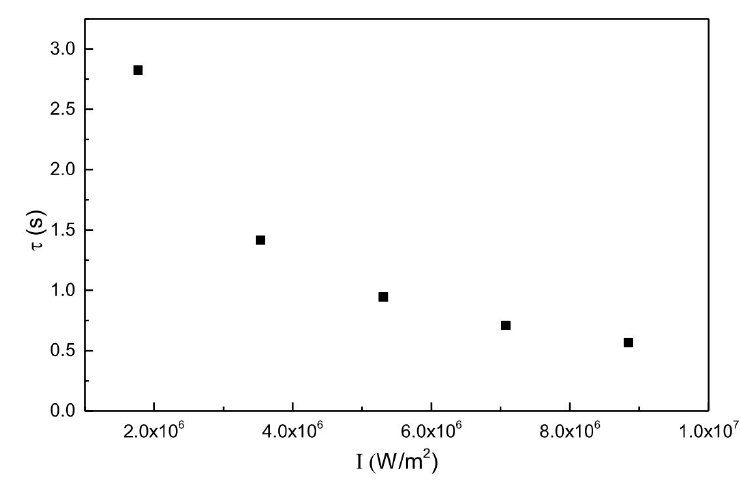
Figure 6. Photovoltaic time constants as function of the pump light intensity in the range (0–9 × 10 6 ) W/m 2 , i.e., in the range of intensities before the change of slope of the curve Δ T vs. I (see Figure 5).